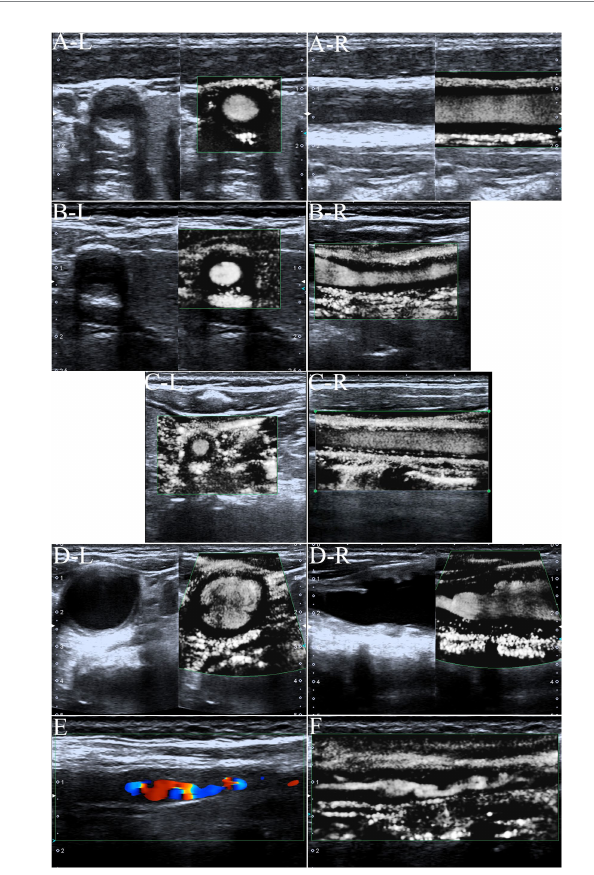
FIGURE 1 The superb microvascular imaging (SMI) of the carotid artery. (A) SMI G0, no visible short lines, dots, or short sticks of medium-high echogenic within the wall of the carotid artery (Left: Transverse section, Right: Longitudinal section). The asterisk marks the bloodstream in the carotid artery canal. The arrow shows the thickened wall of the carotid artery. (B) SMI G1, moderate visible short lines, dots, or short sticks of medium-high echogenic within the wall. The arrow shows neovessels in the thickened wall of the carotid artery (Left: Transverse section, right: Longitudinal section). (C) SMI G2, extensive visible short lines, dots, or short sticks of medium-high echogenic within the wall of the carotid artery. The arrow shows neovessels in the thickened wall of the carotid artery (Left: Transverse section, right: Longitudinal section). (D) Carotid lumen expansion and aneurysm formation (Left: Transverse section, Right: Longitudinal section). The asterisk marks the bloodstream in the carotid artery canal. The arrow shows neovessels in the thickened wall of the carotid artery aneurysm. (E) Color Doppler flow imaging showing carotid stenosis and segmental occlusion. (F) In contrast with (E) , SMI was able to clearly show low blood flow signals in the same carotid stenosis and segmental occlusion cavities.